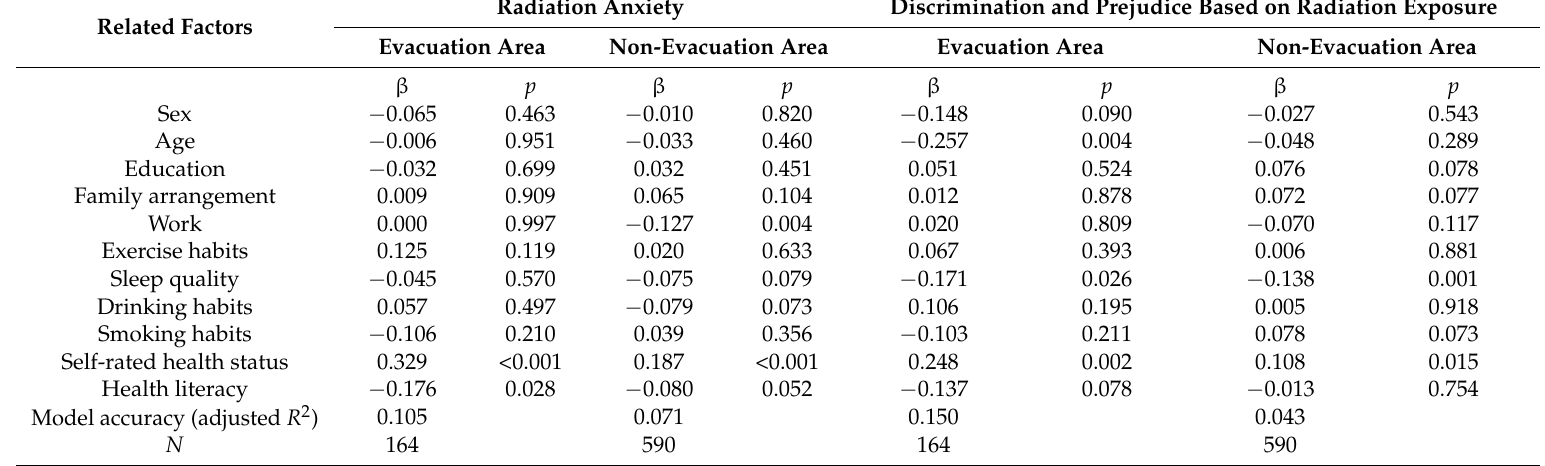
Table 4. Radiation anxiety and stigma-related factors in each